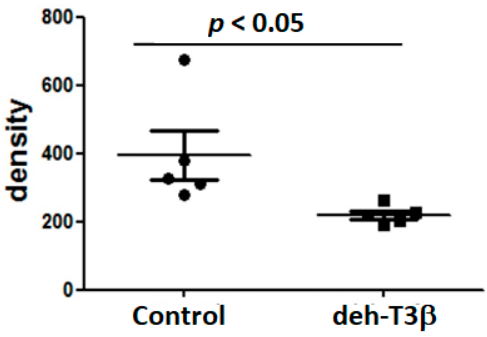
Figure 6. Antioxidant capacity of deh-T3 β in red blood cells from non-treated db/db mice (control) and red blood cells from mice treated with deh-T3 β for one month by diet.